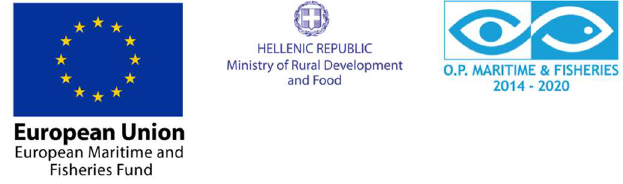
T, (cid:52) TC, T50). (cid:51) (cid:35)